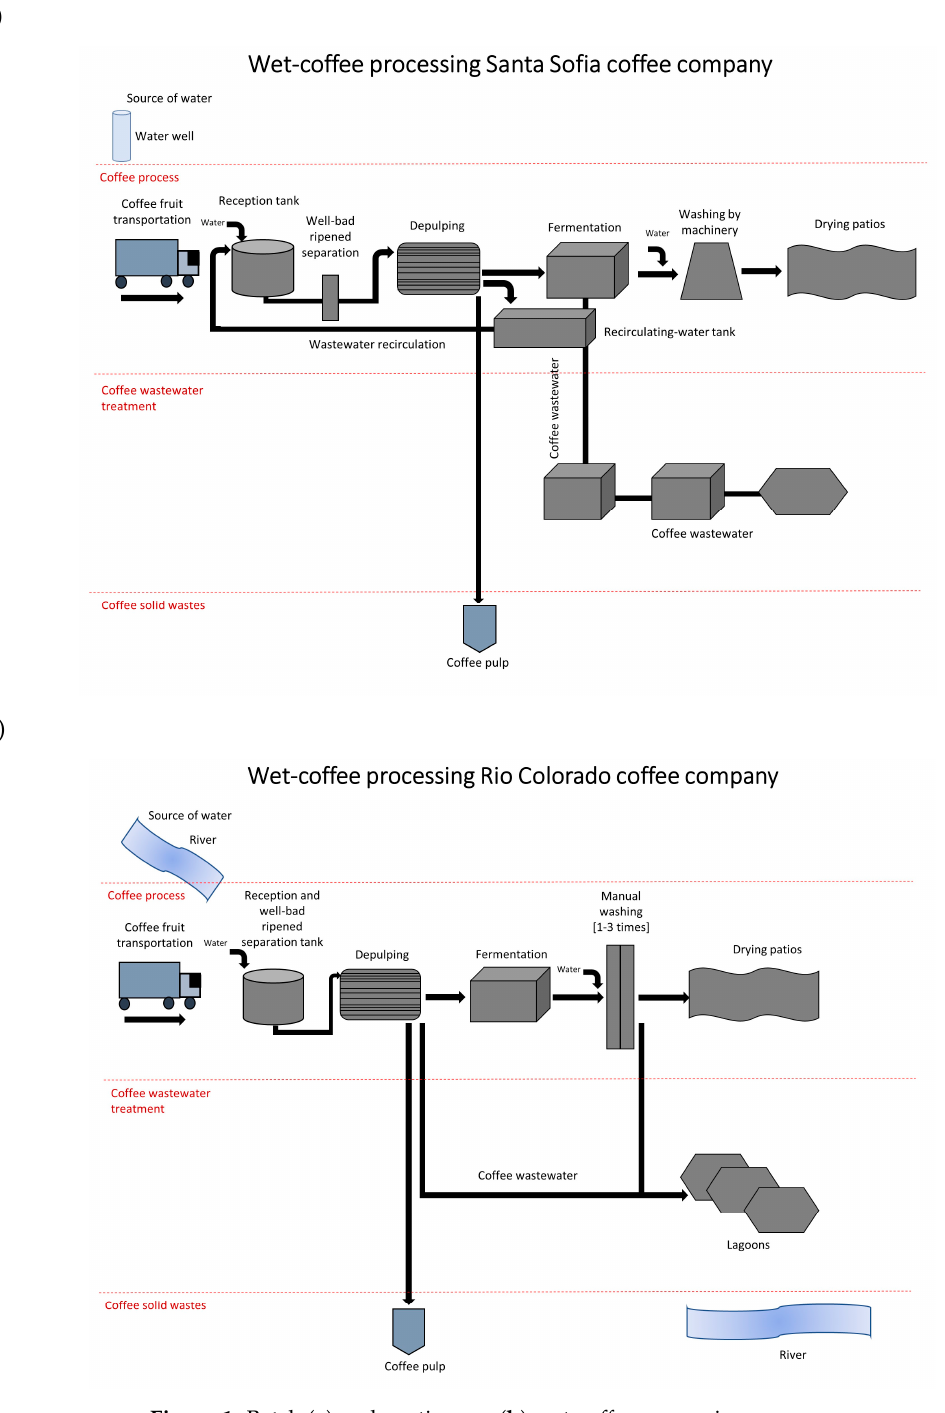
Figure 1. Batch ( a ) and continuous ( b ) wet-coffee processing.